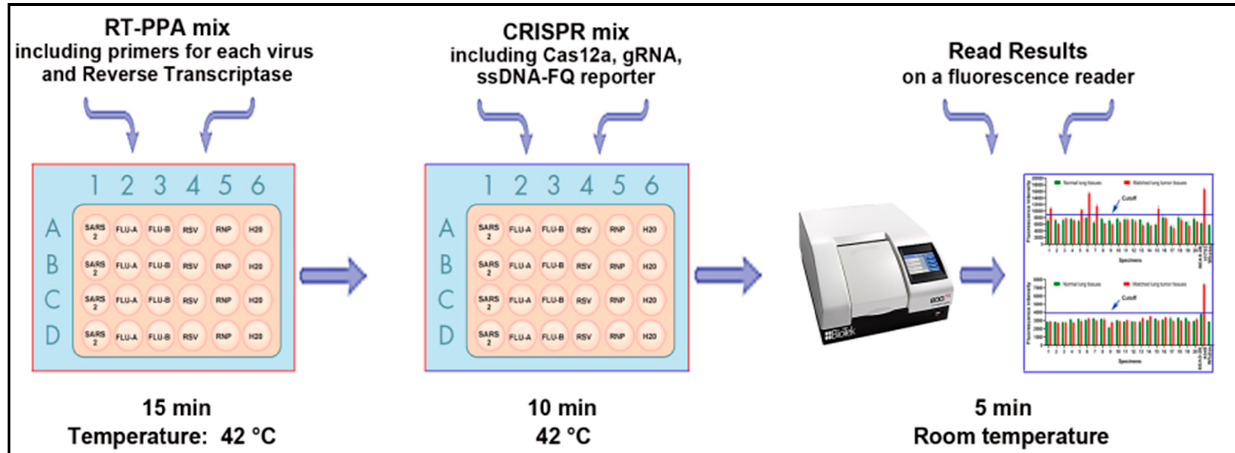
Figure 1. The workflow of the plate-based CRISPR for detection and differentiation of viruses. First, a 10 µ L RT-RPA reaction containing 0.48 µ M forward and reverse primers, a 6 µ L primer-free rehydration buffer, RNA, 14 mM MgOAc, and 200U/ µ L reverse transcriptase was